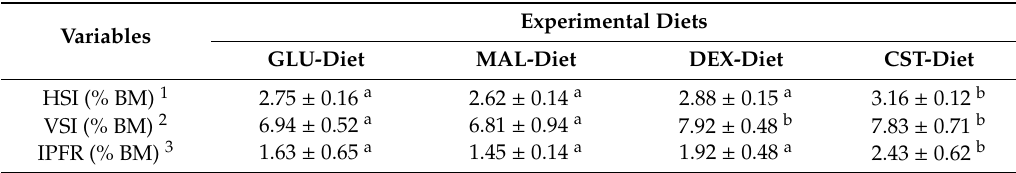
Table 4. Slaughter indices (HIS, VSI, and IPFR; % of body mass (BM)) of juvenile Nile tilapia fed the experimental